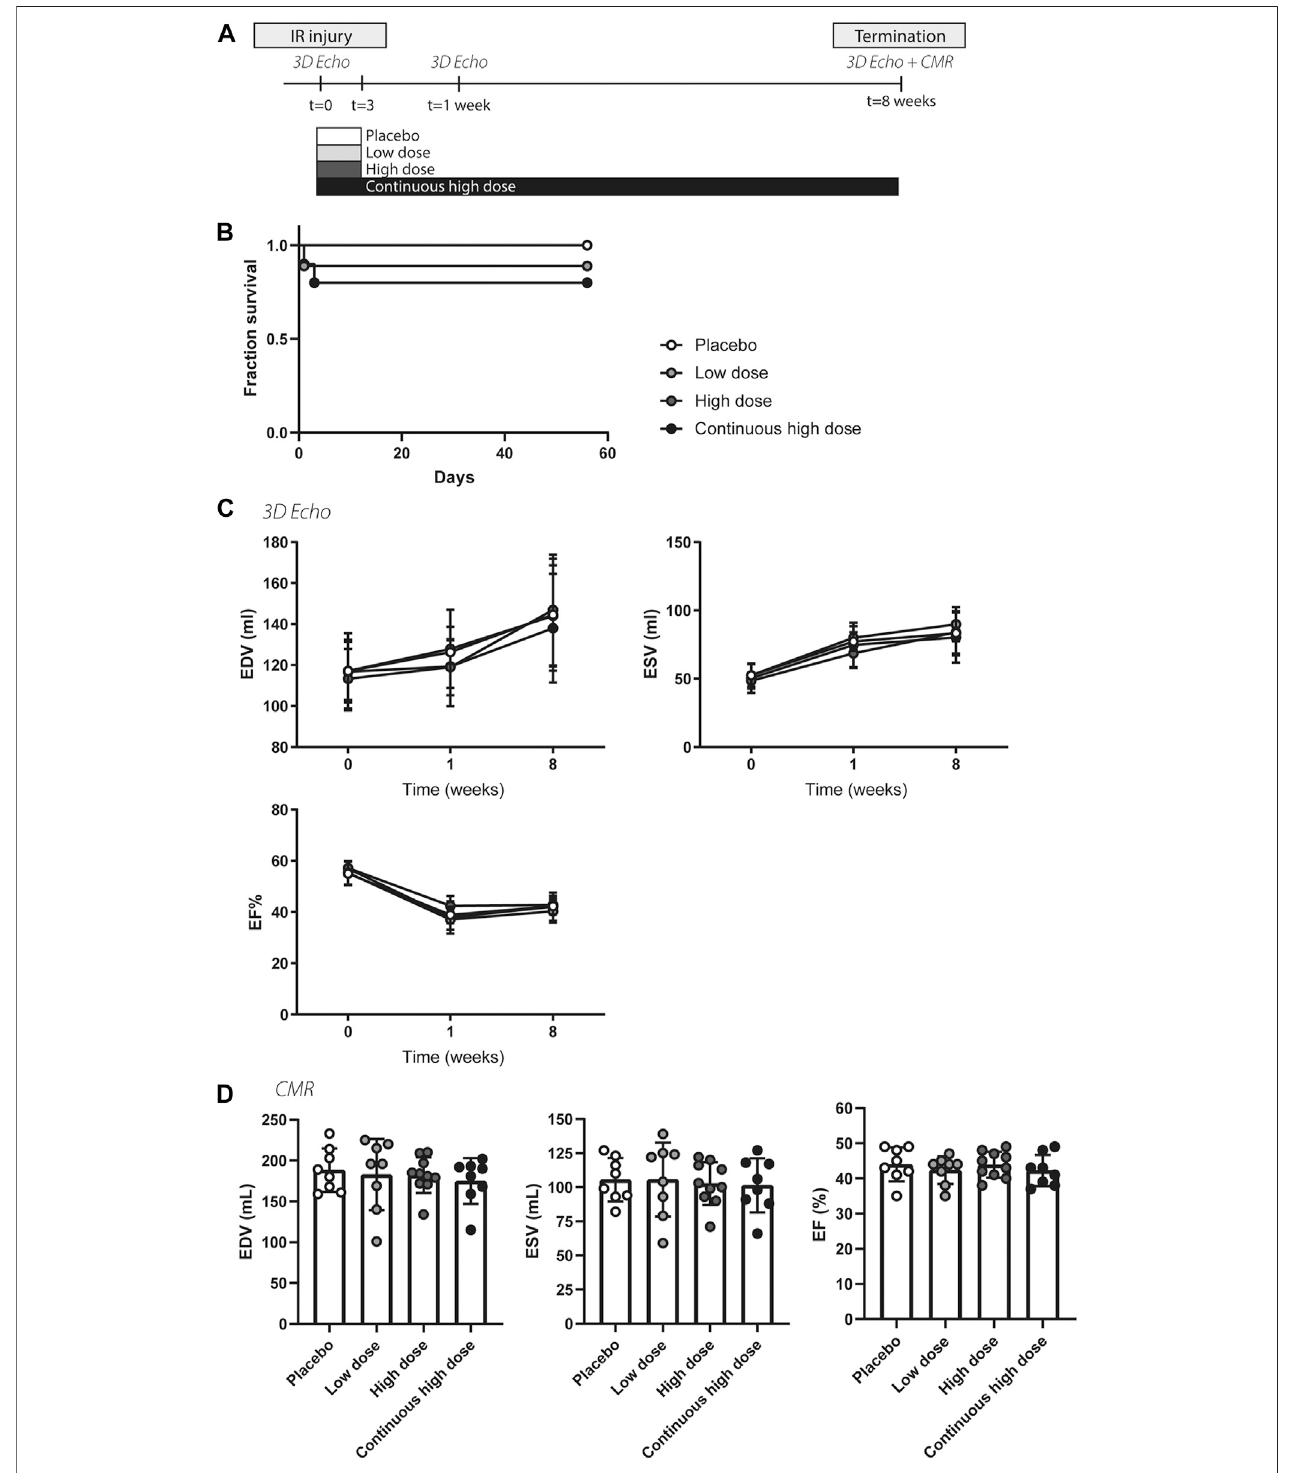
FIGURE 1 | Study design, survival, and global cardiac function of porcine animals after severe ischemia-reperfusion injury. (A) Overview of the porcine study. (B) Fraction of survival of the different treatment groups, placebo, low dose, high dose, continuous high dose over the entire follow-up. IR, ischemia-reperfusion. (C) Similar end-systolic volume (ESV), end-diastolic volume (EDV), and ejection fraction (EF%) at baseline, 1 and 8 weeks post-IR measured by 3D echocardiography between different experimental groups. (D) ESV, EDV, and EF% at 8 weeks post-IR measured by cardiac magnetic resonance imaging did not differ between groups.